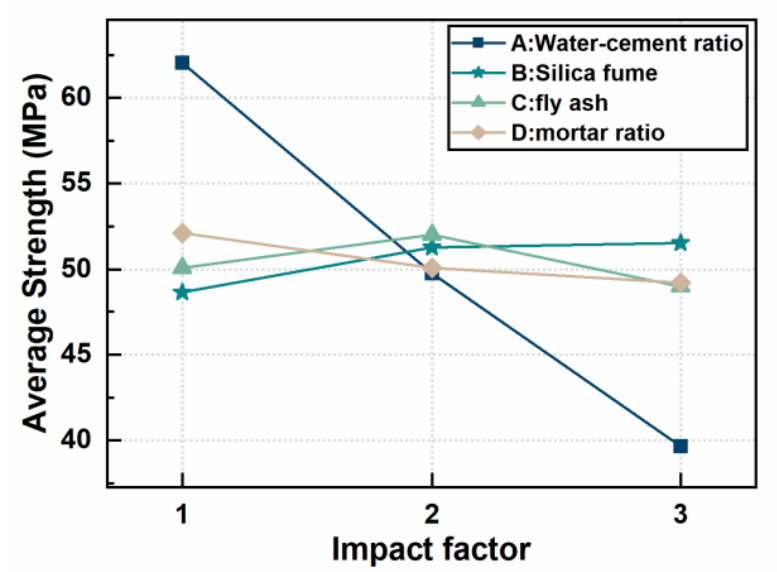
Figure 1. Comparison chart of three indicators of four impact factors.